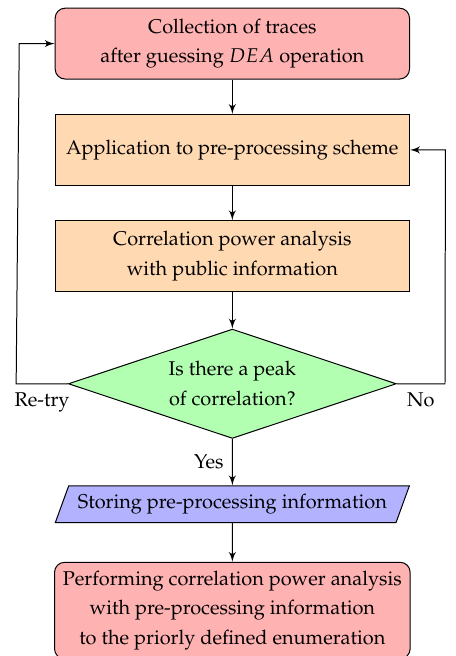
Figure 3. Security evaluation methodology for financial IC card